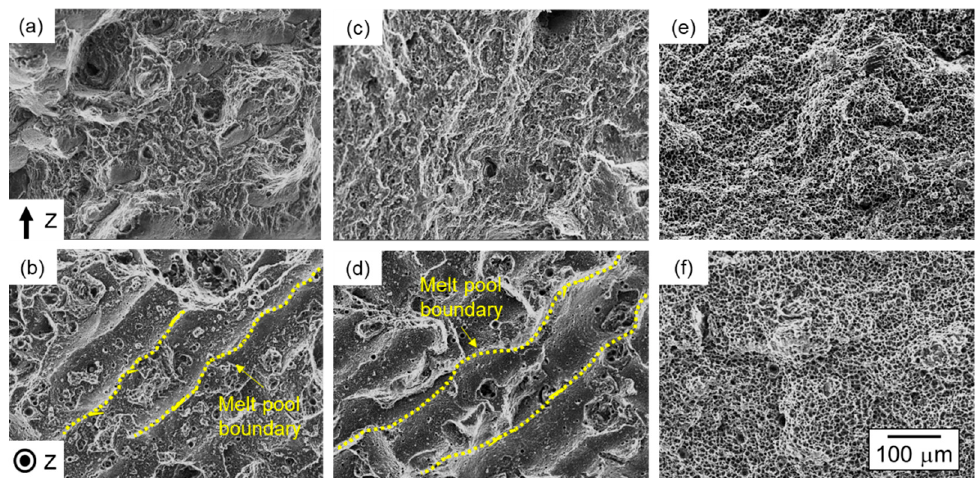
Figure 12. Fracture morphology of ( a , b ) as-fabricated, ( c , d ) 300 °C /2 h annealed, ( e , f ) 530 °C/6 h annealed samples observed from ( a , c , e ) the sections normal to the building direction (z axis); ( b , d , f ) the sections parallel to the building direction (z axis).